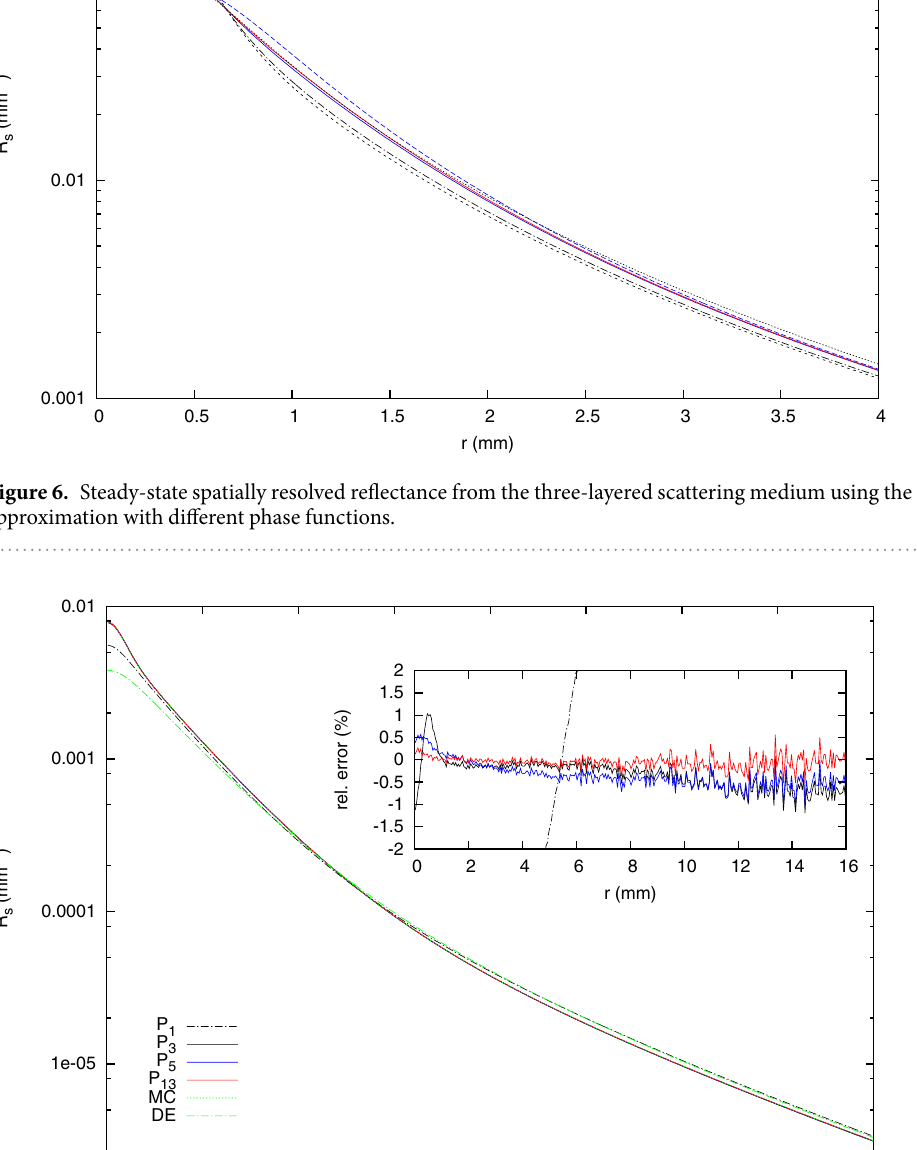
(1) . The system is e